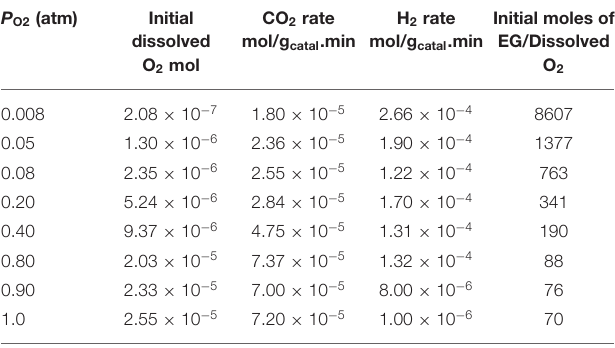
TABLE 2 | H 2 and CO 2 production rates and initial concentrations of dissolved O 2 . P O2 (atm) Initial dissolved O 2